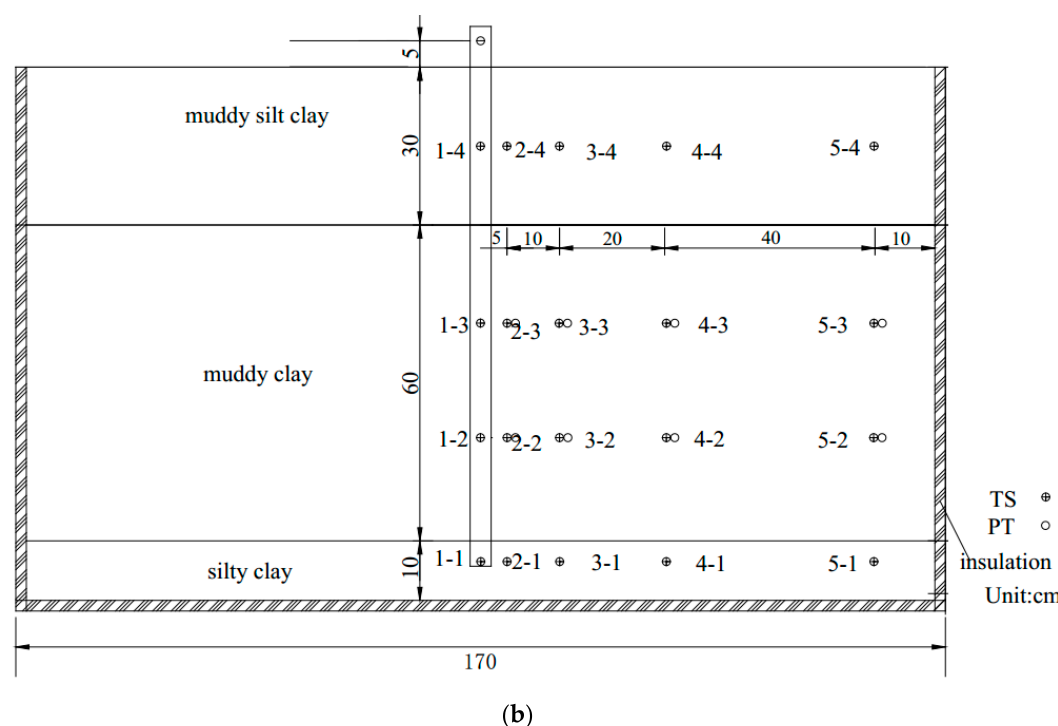
Figure 4. Experimental model box: ( a ) model soils distribution; ( b ) sensors.